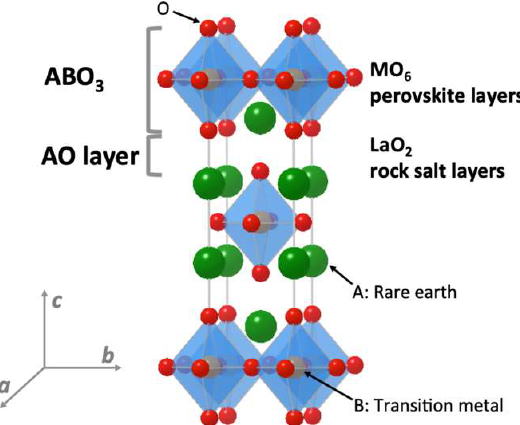
Figure 6. Schematic crystal structure of RP oxides, where A and B are a rare earth and transition metal